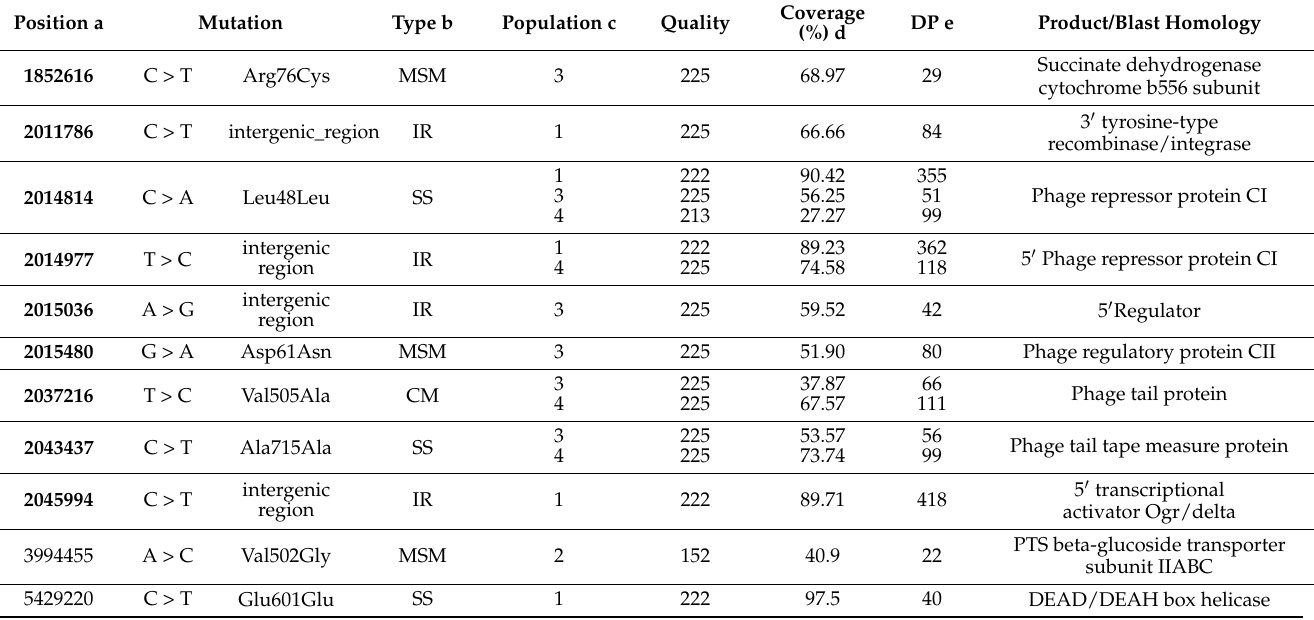
a In bold, mutations localized inside the region that is amplified in the evolved populations. b Type of mutation that causes the single nucleotide polymorphism (SNP). SS, synonymous substitutions; MSM, missense mutation; CM, conservative mutation and IR, intergenic regions. c Number corresponds with evolved population in supra-inhibitory concentration of colistin (Table 2). d Percentage of reads with mutation in relation to total reads. e Number of